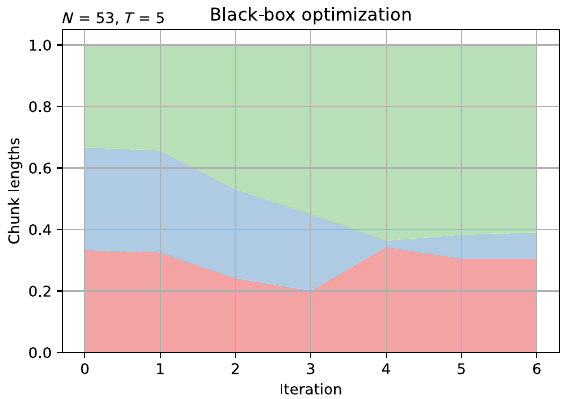
FIG. 10. An instance of a black-box optimizer for the case when crossing a phase transition, here for J = 3 and N = 53. The stacked chunk lengths are shown for the first nine iterations as the middle chunk becomes smaller. This leads to the evolu- tion time being spent effectively around the smallest gap around s ≈ 0.34. In this instance, the final fidelity is nearly 7 times larger using the VQAA compared with a linear